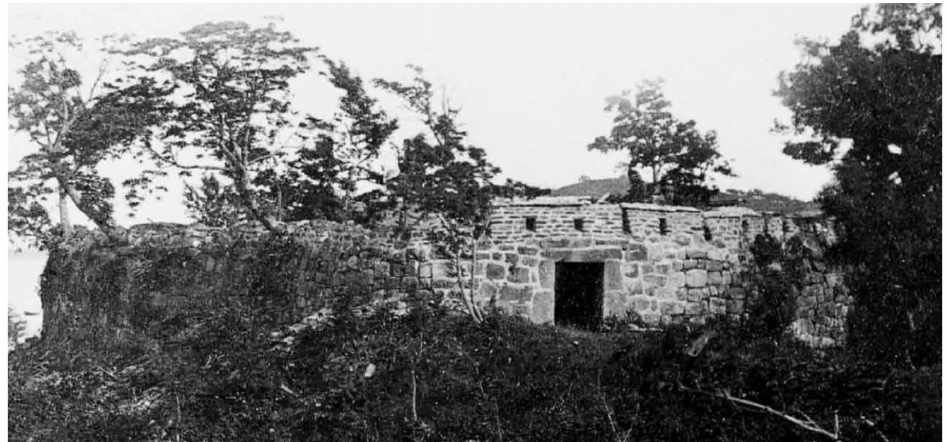
Figure 3. Choji Dondae. Photograph taken by the U.S. Reprinted with permission from Ref. [11]. 2014, Gangwha